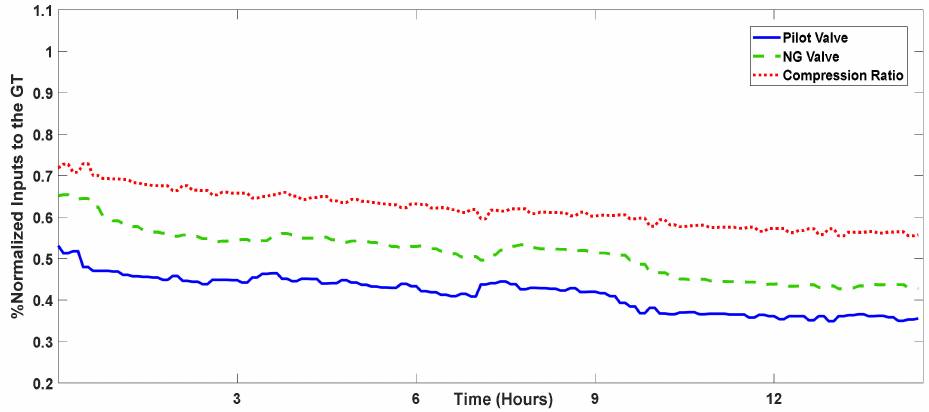
Figure 12. Normalized inputs to the